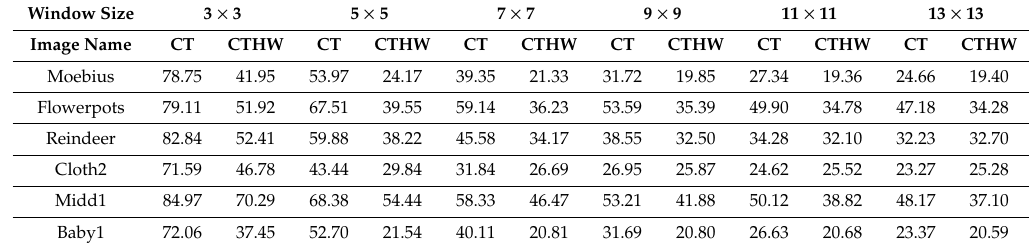
Table 1. The results of CTHW and CT with percentages of bad matching pixels (PoBMP) (%). Window